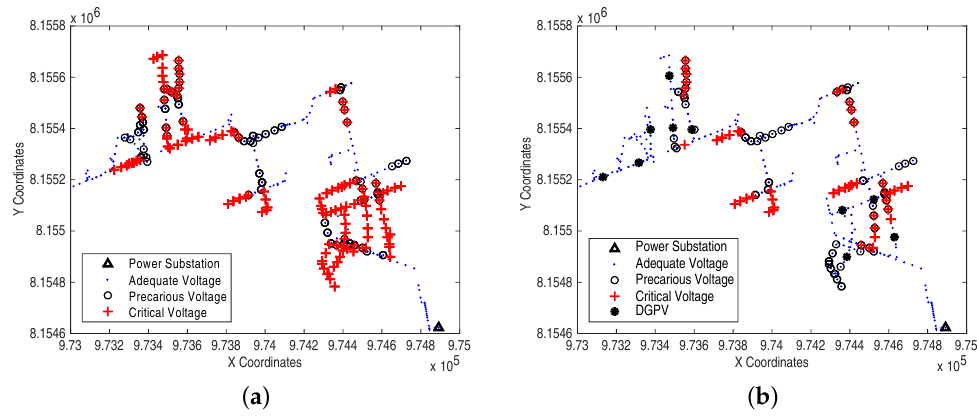
Figure 23. Optimization without restriction of buses: ( a ) voltage rating before DGPV allocations and ( b ) voltage rating after DGPV allocations.